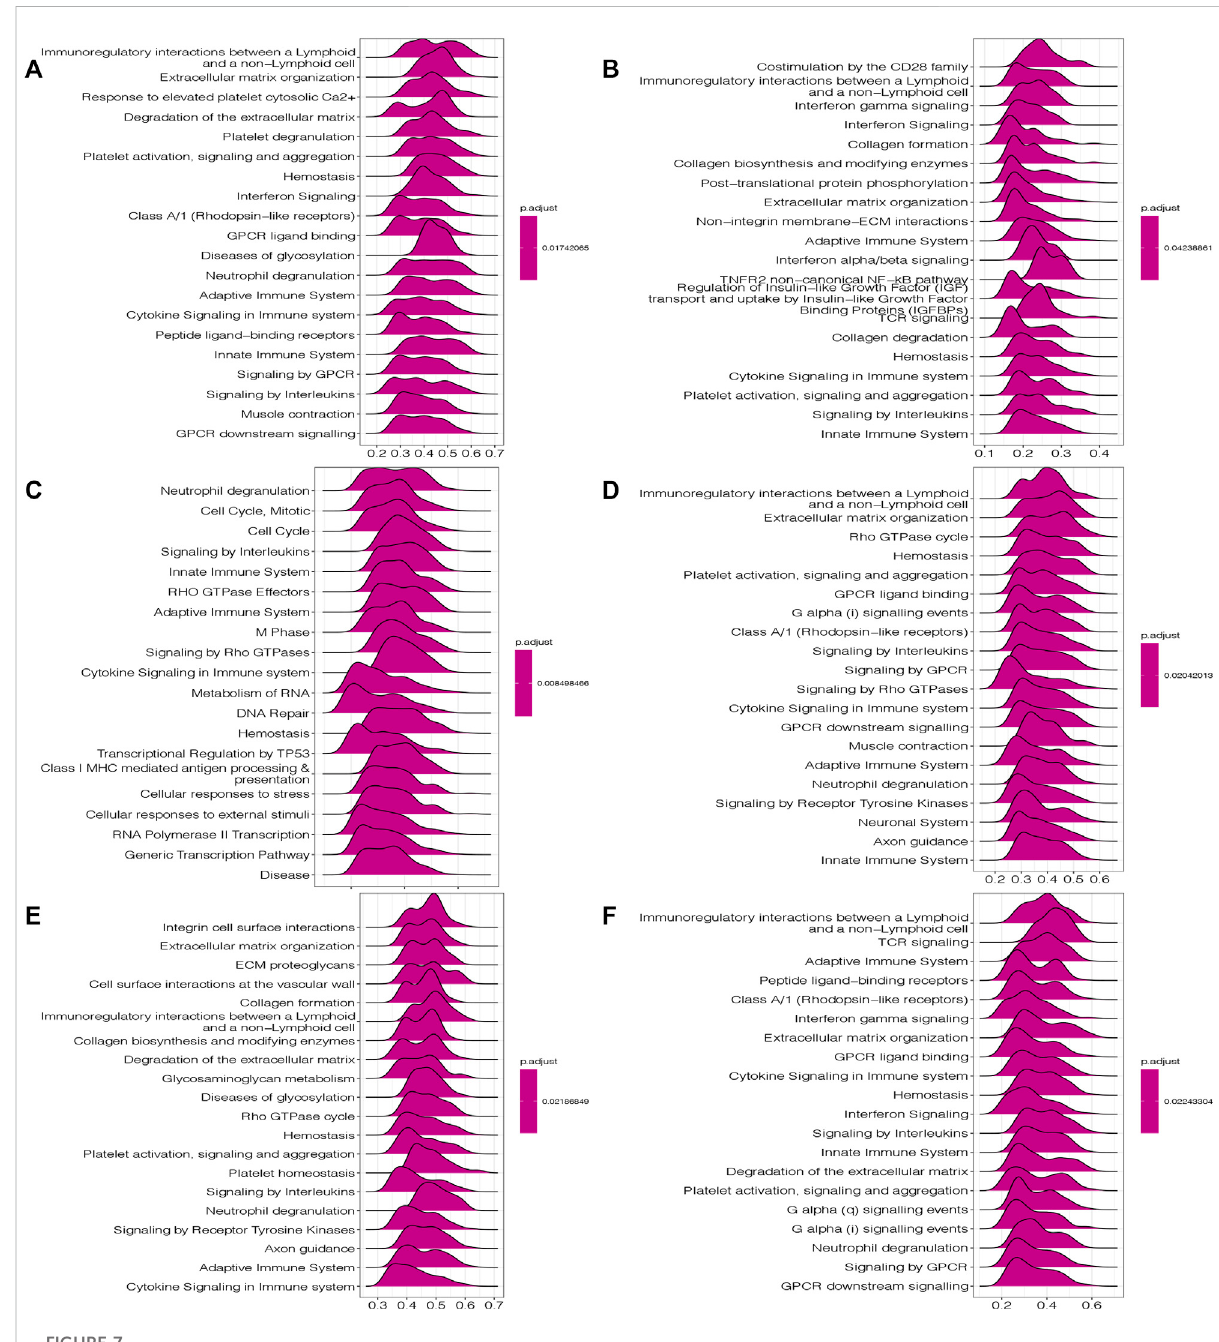
FIGURE 7 GSEA results of HOXC4 expression involved in Reactome pathways (A) COAD; (B) HNSC; (C) LGG; (D) LIHC; (E) READ; (F)